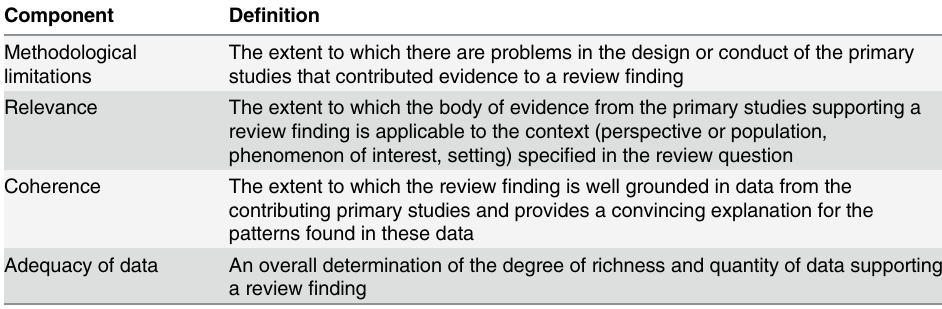
Table 1. Components of the CERQual